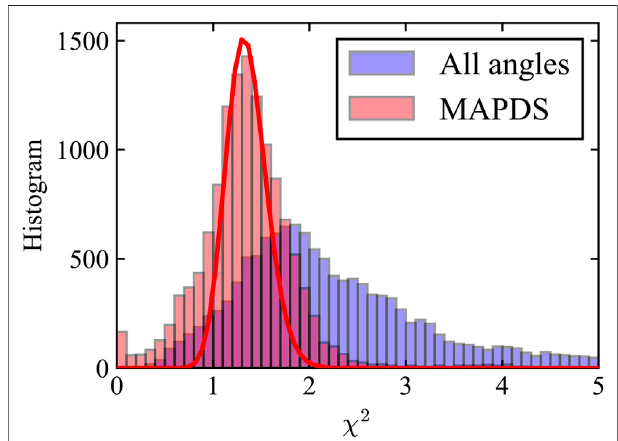
FIGURE 10 | Histogram of the χ 2 for Figure 8 (C1) (with all angles) and (C2) (with MAPDS) with its most probable values of 1.85 and 1.35 respectively. The average number of measurements including both re fl ectance and DoLP used in the retrievals are 112 and 85 respectively. The theoretical curve (red line) is for 85 degrees of freedom, shifted to the same most probable value of 1.35 as the histogram.